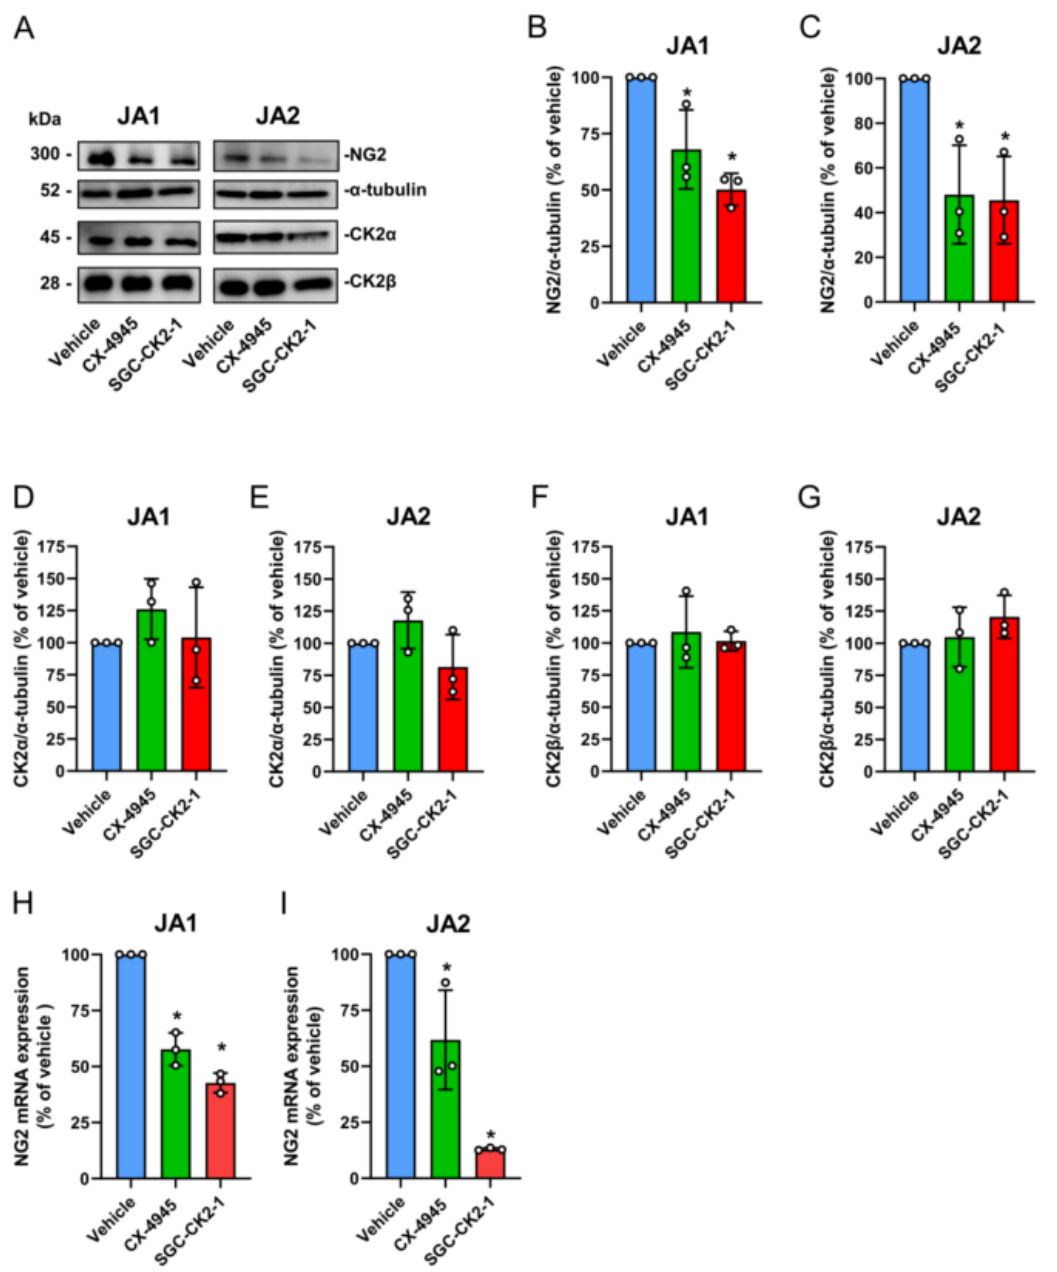
Figure 4. CK2 inhibition reduces the NG2 expression of the JA cells. ( A – D ) The JA1 and JA2 cells were treated with CX-4945 (10 µ M) and SGC-CK2-1 (5 µ M) for 48 h. Vehicle-treated cells served as controls. The cells were lysed and the expression of NG2, CK2 α , CK2 β and α -tubulin (as a loading control) was assessed by Western blot. The relative density ratio of NG2/ α -tubulin ( B , C ), CK2 α / α -tubulin ( D , E ) and CK2 β / α -tubulin ( F , G ) was determined and the vehicle-treated cells were set at 100%. Mean ± SD ( n = 3). * p < 0.05 vs. vehicle. ( H , I ). The gene expression of NG2 was measured by qRT-PCR. Vehicle-treated cells were set at 100%. Mean ± SD ( n = 3). * p < 0.05 vs.